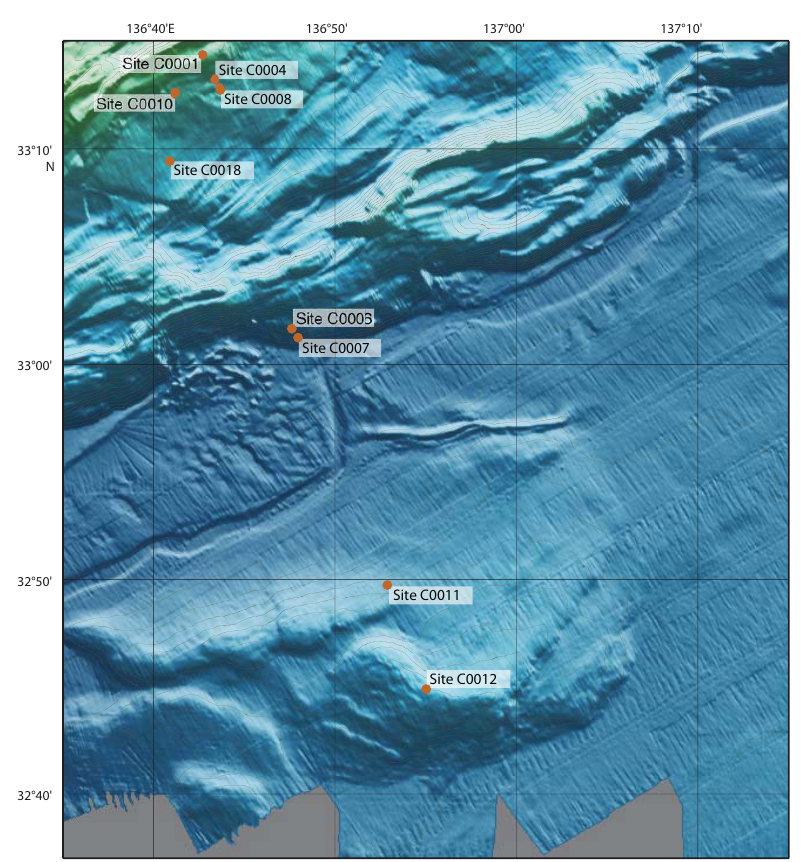
Figure 2. Detailed bathymetric map of Kashinosaki Knoll and Nankai Trough showing location of Sites C0011, C0012, and